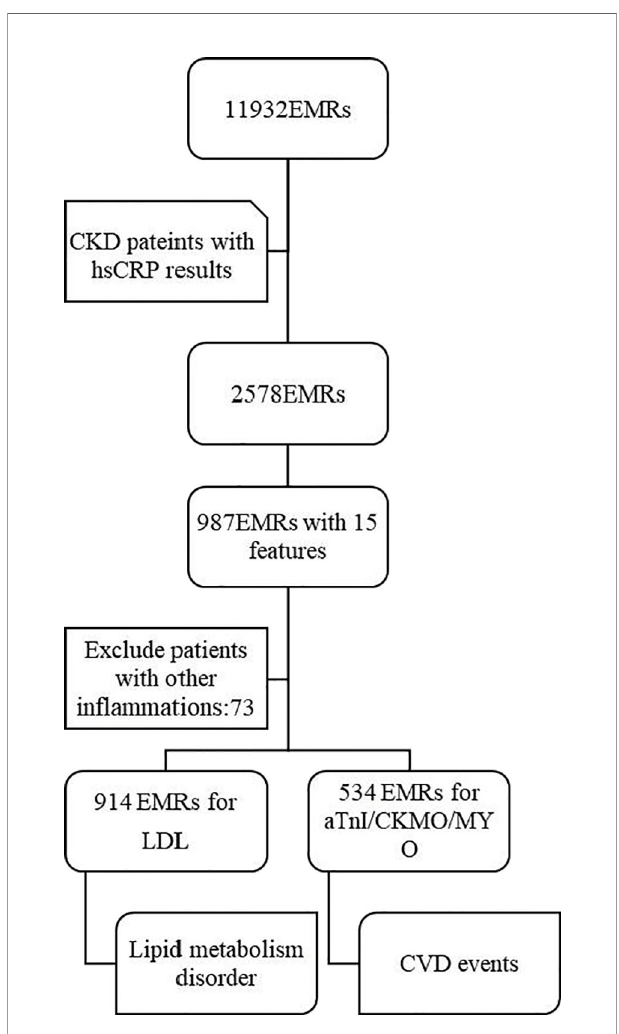
FIGURE 1 | Study population. From the initial database with 11932 EMRs, 2578 EMRs of CKD patients with hsCRP results were selected fi rstly. Then, among the 987 EMRs with complete 15 features included, 73 EMRs were excluded. Finally, 914 EMRs and 534 EMRs were used for prediction for lipid metabolism disorder and CVD events respectively. EMRs, Electronic Medical Record; CKD, Chronic kidney disease; hsCRP, hypersensitive C-reactive protein; LDL, low-density lipoprotein; CK-MB, creatine kinase isozyme; MYO, myoglobin; aTnI, Troponin I; CVD, cardiovascular